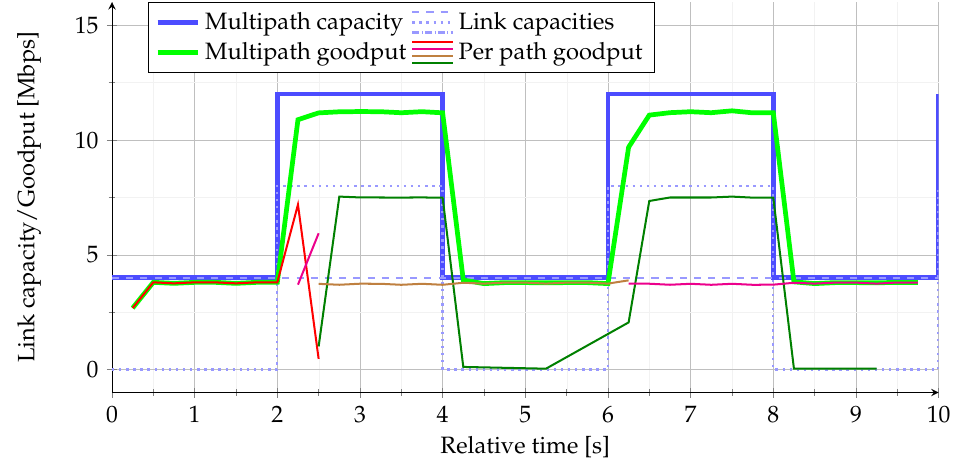
Figure 6. QUIC in an idealized